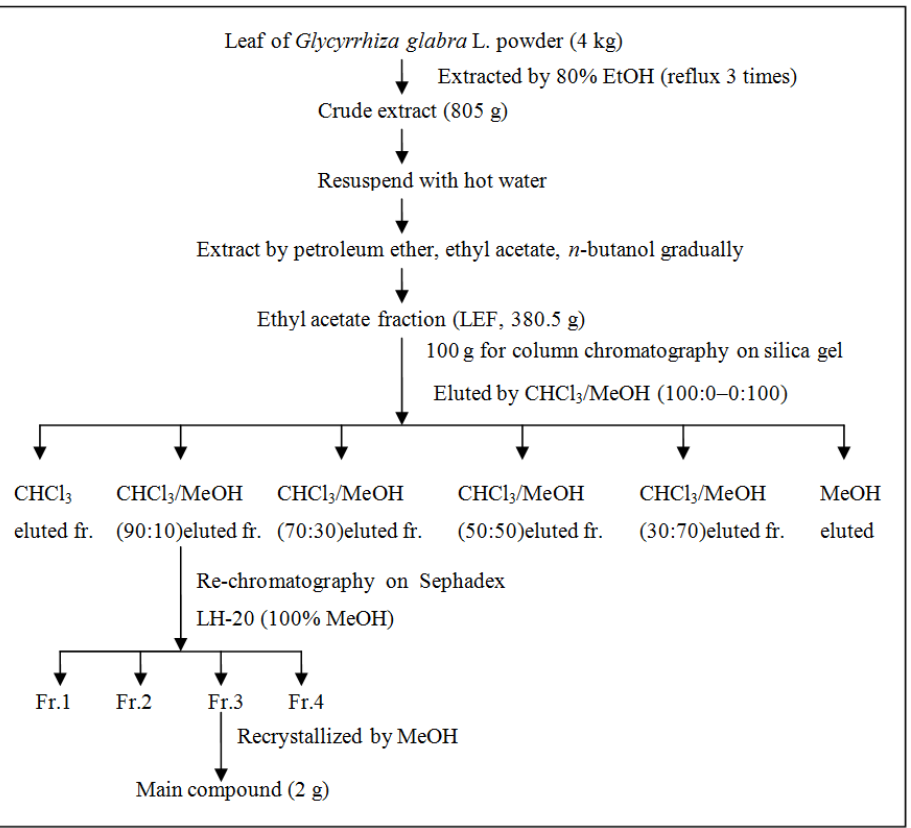
Figure 4. Isolation and purification of the main compound from ethyl acetate fraction (LEF) of Glycyrrhiza glabra L. leaf. Fraction 1, 2, 3 was abbreviated as Fr. 1, 2,